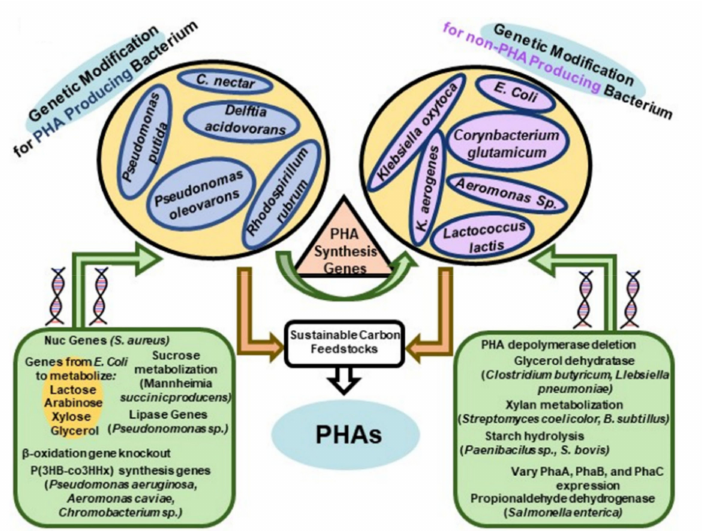
Figure 5. Genetic engineering strategies to improve bacterial strains for PHA production. PHA producing strains can be improved to convert various carbon substrates into PHAs via gene insertion or deletion. PHA synthase genes from PHA producing strains are often inserted in non-PHA producing strains. Using different strains of bacteria facilitates PHA production under conditions that are not suitable for naturally producing PHA